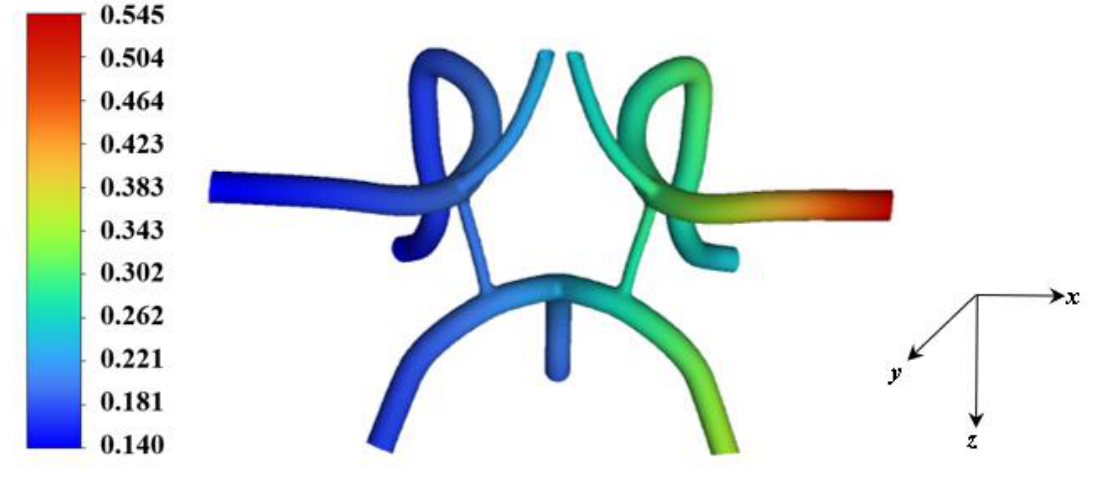
Figure 7. Contour of the arterial magnetic field strength at B r = 2.0T over the entire fluid arterial domain generated in ANSYS Fluent.